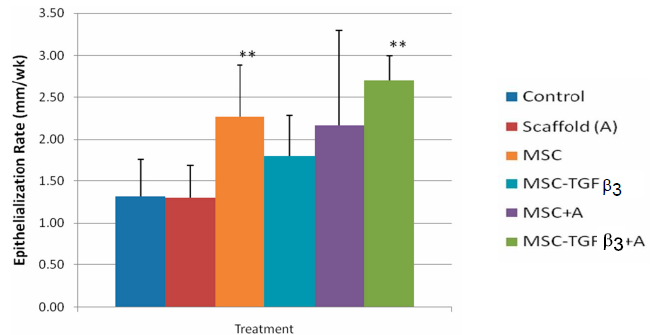
Figure 6. Epithelialization rates at 1 week following surgery. ** indicates statistical significance between treatment and control. ** indicates statistical significance between two treatments ( p < 0.05) [22].